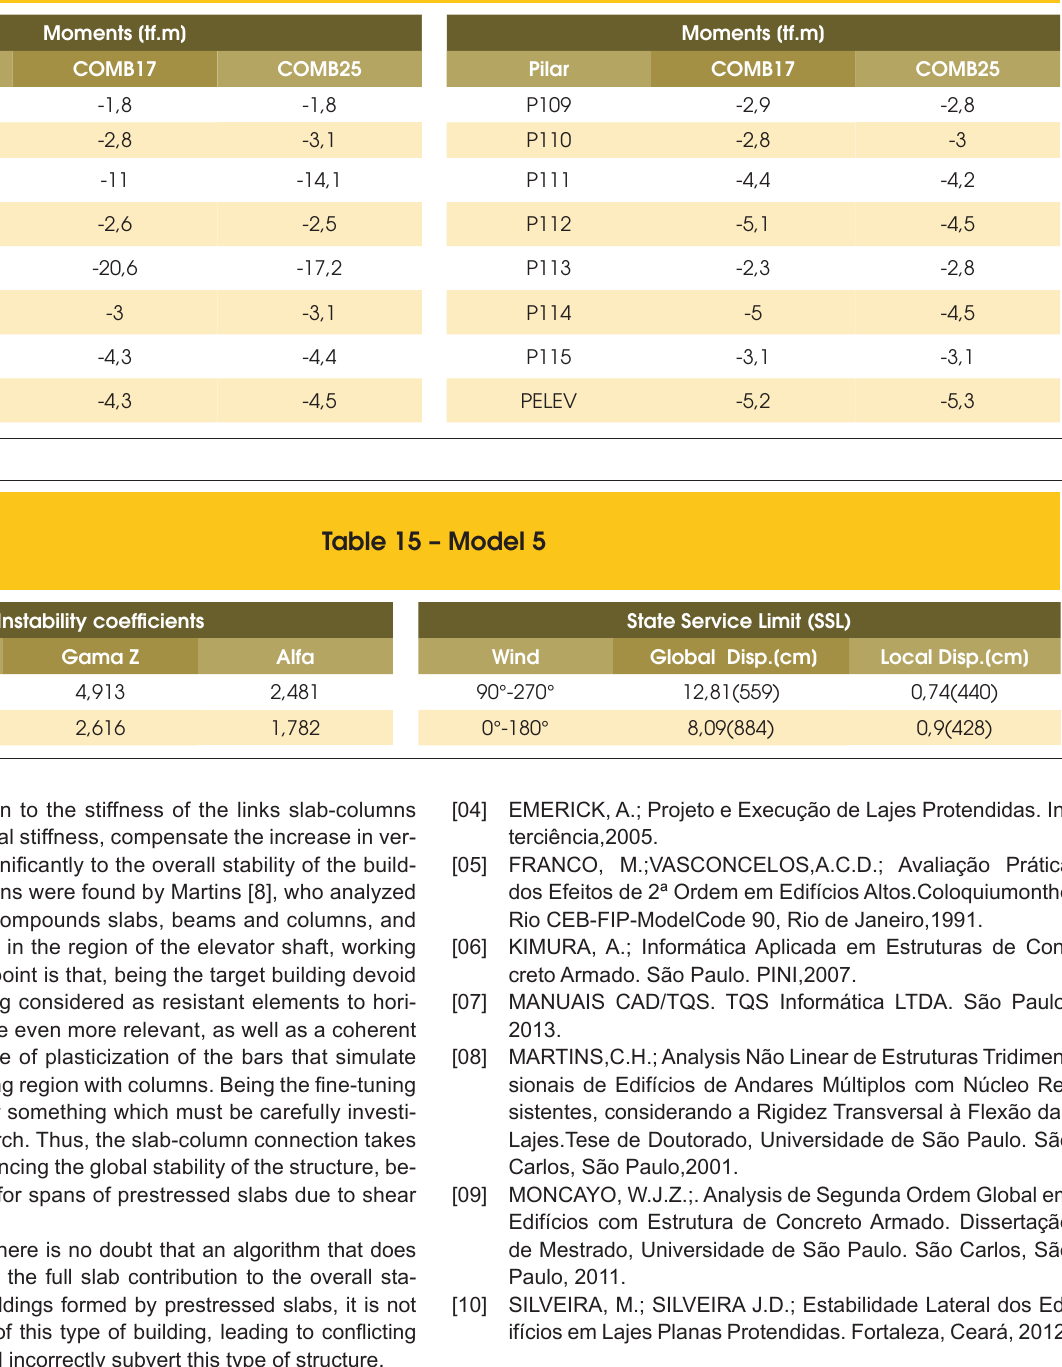
Table 14 – Moments in the region of the Coluns Model 4 - 4ª Analysis Moments